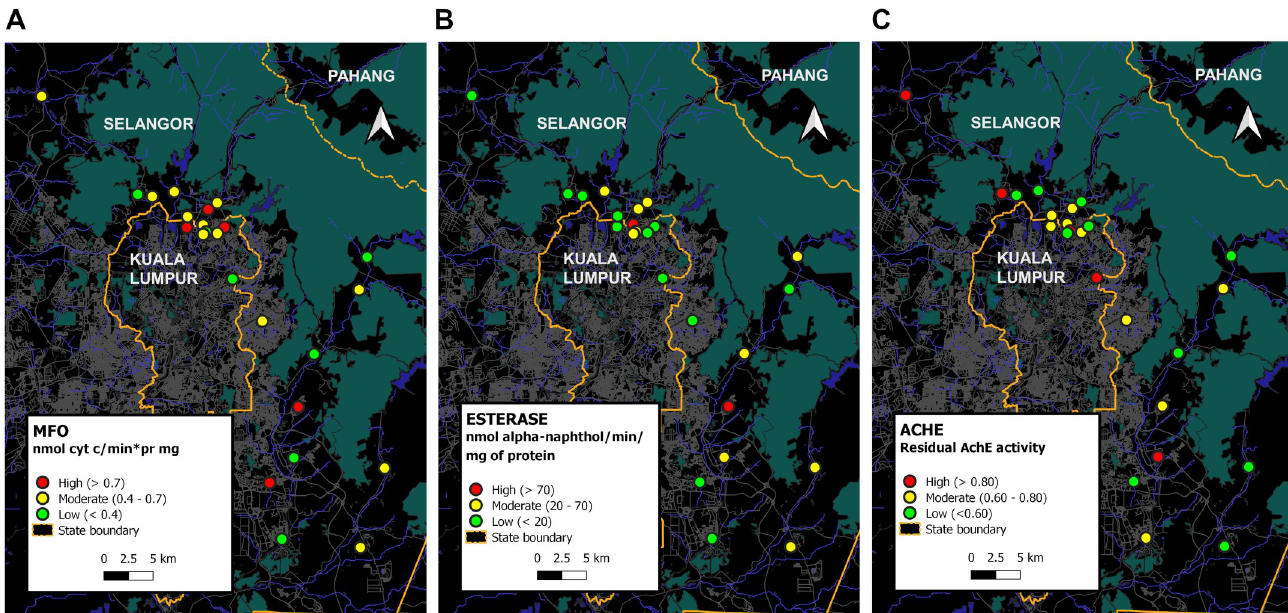
Fig 3. Enzyme Mix function oxidase (MFO), esterase and residual acetylcholinesterase (AChE) activity in collected Aedes aegypti populations.